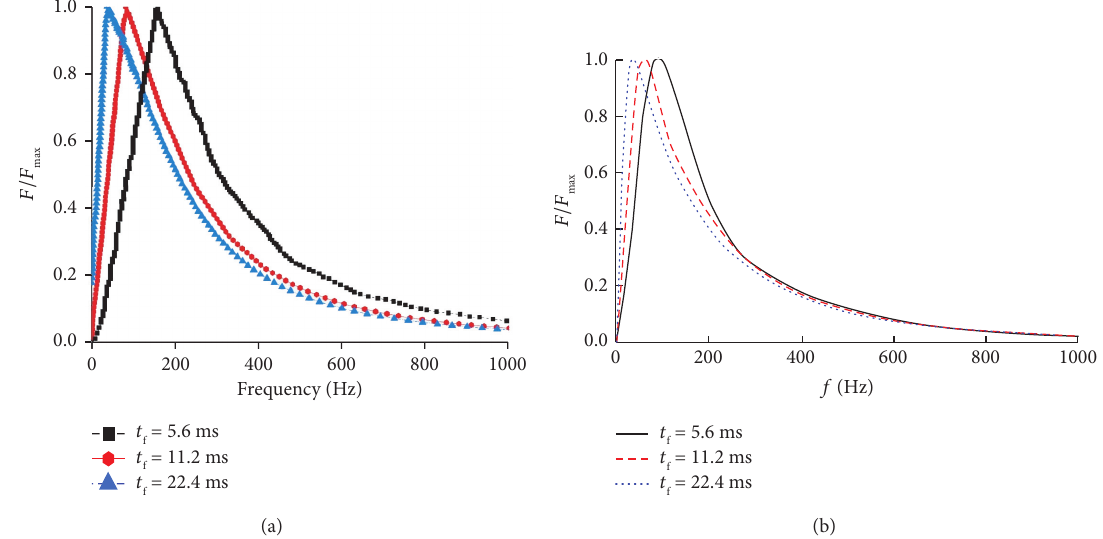
Figure 3: The effect of falling time on the frequency content: (a) in this study; (b) Yang et al. [25].